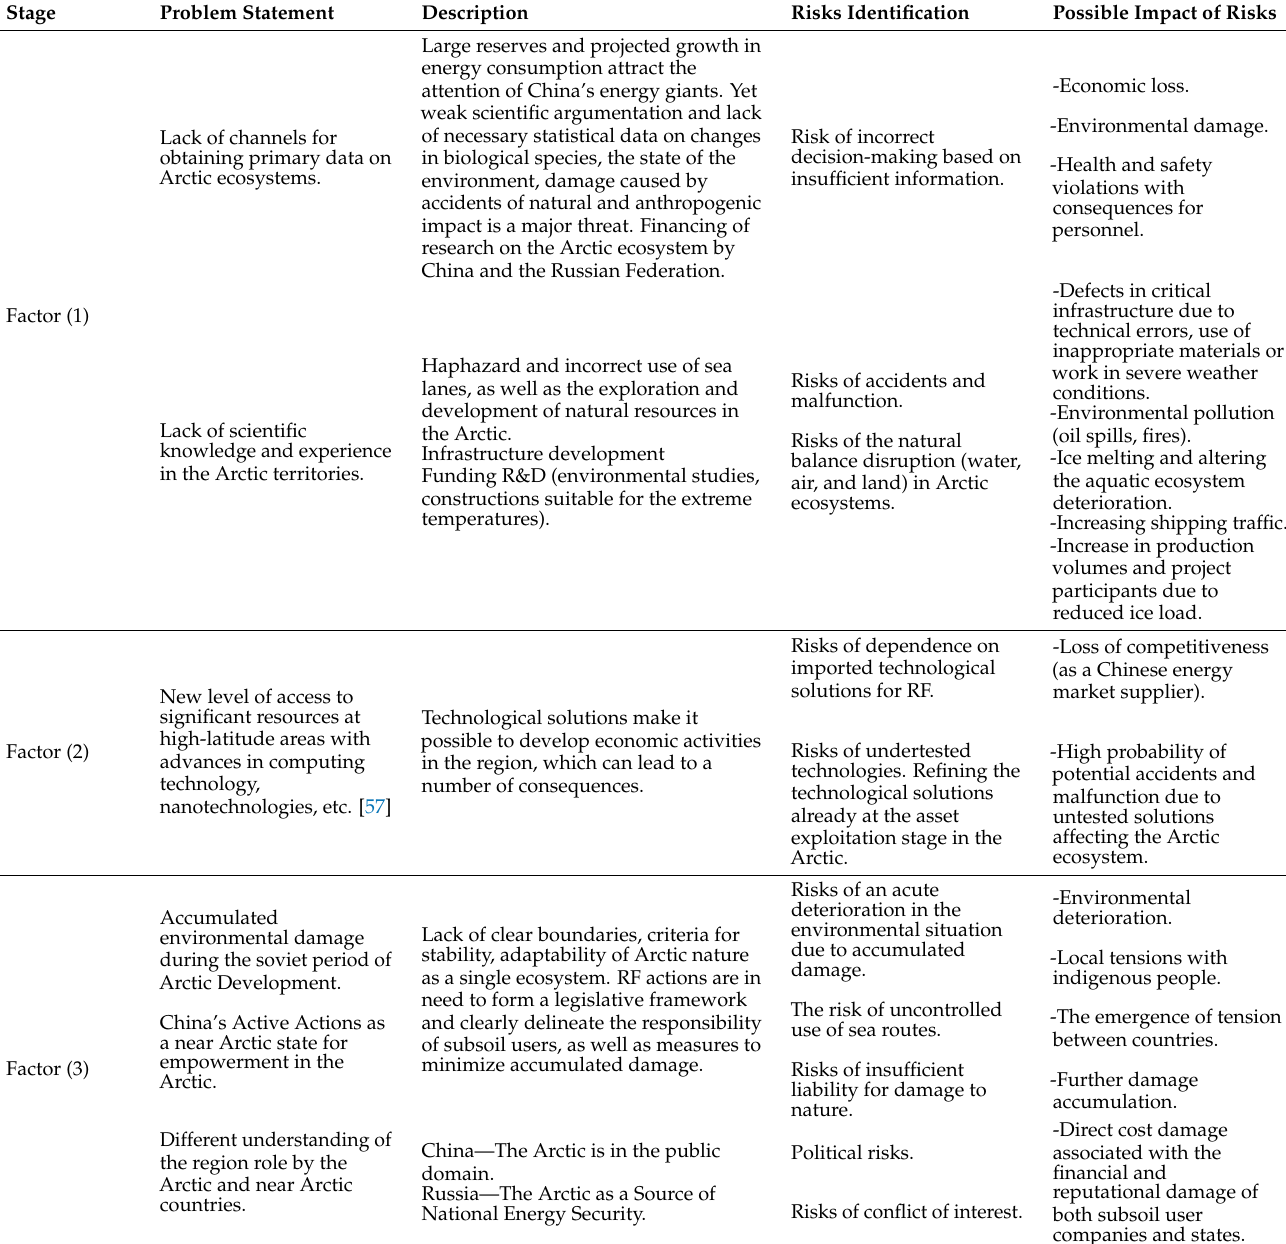
Table 9. An algorithm for identification of environmental risks in the system of Sino-Russian relations in the development of the Arctic